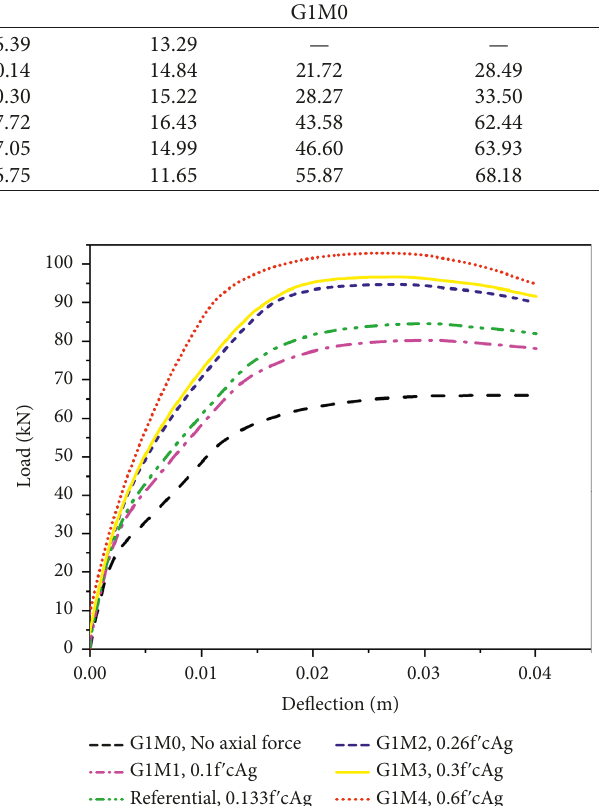
Figure 14: Load-deflection response of specimens with different axial load ratios.